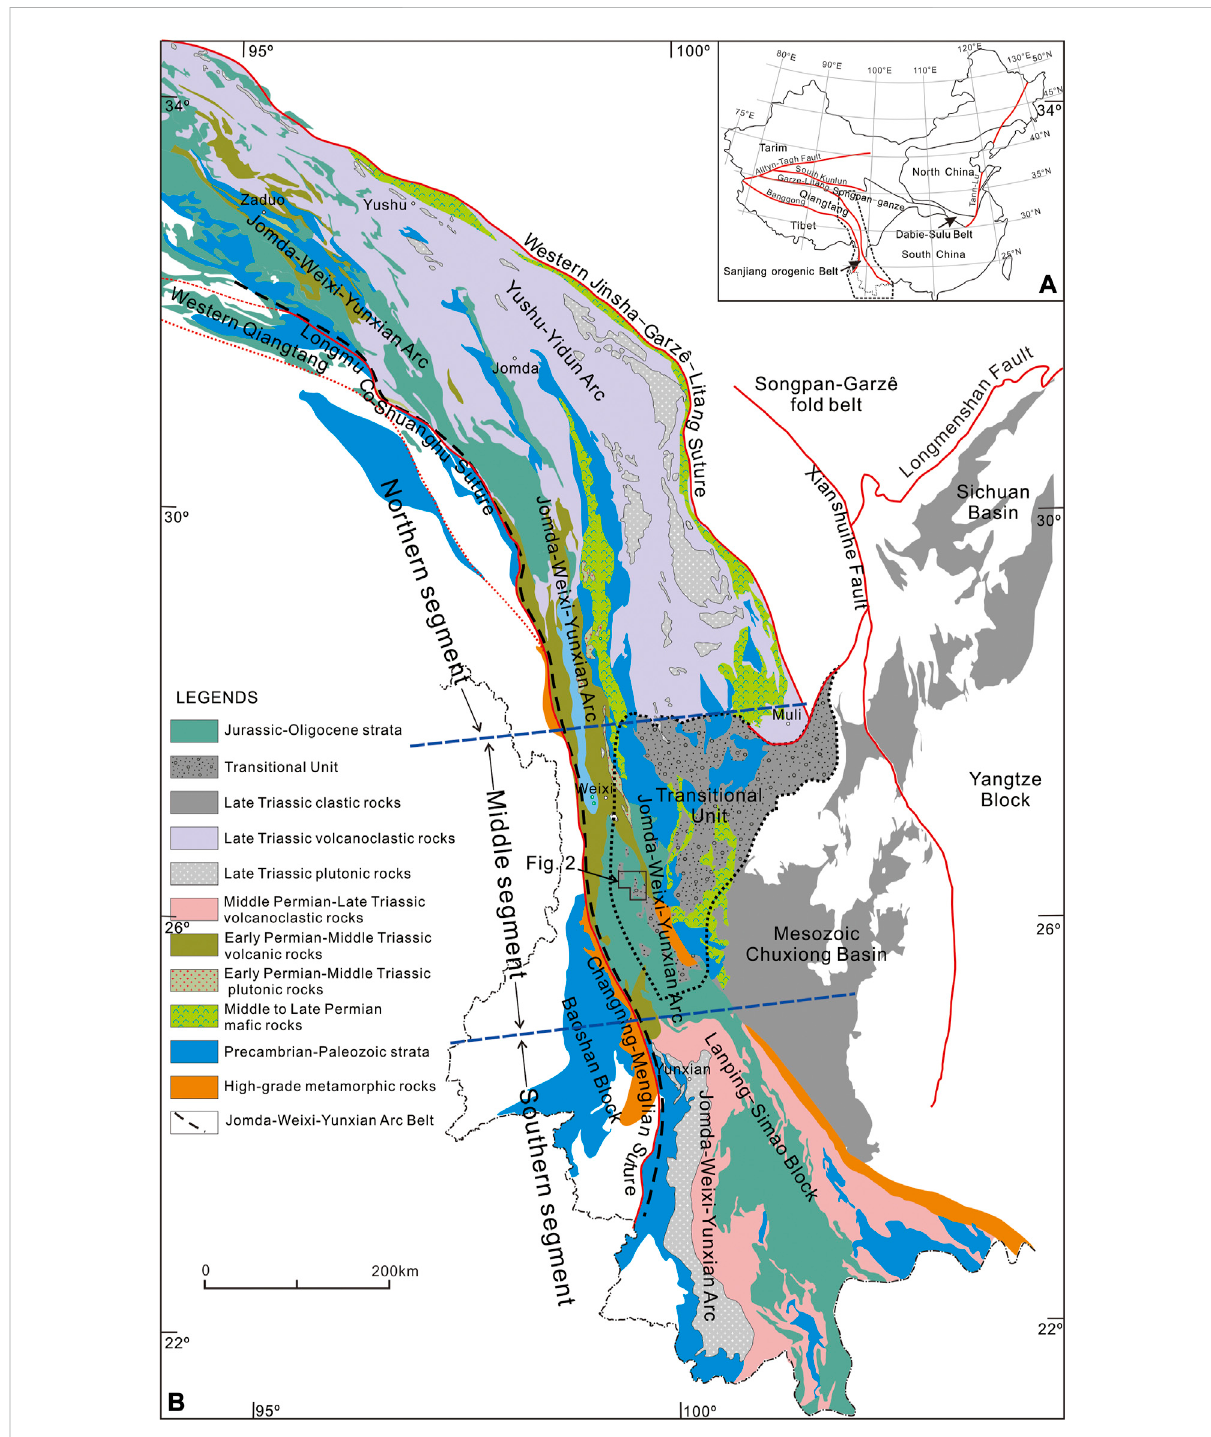
FIGURE 1 (A) Tectonic framework of China mainland showing the location of the Sanjiang orogenic belt. (B) Simpli fi ed geological map of the Sanjiang orogenic belt showing the tectonic framework and the locations of the Transitional Unit (thick dash-line) and the study area (the solid polygon) (modi fi ed after ECSGM, 1986; Burch fi el and Chen, 2012; Yang et al., 2014, 2021). The two blue dashed lines are the approximate boundaries separating the northern, middle, and southern segments of the Jomda – Weixi – Yunxian arc belt,